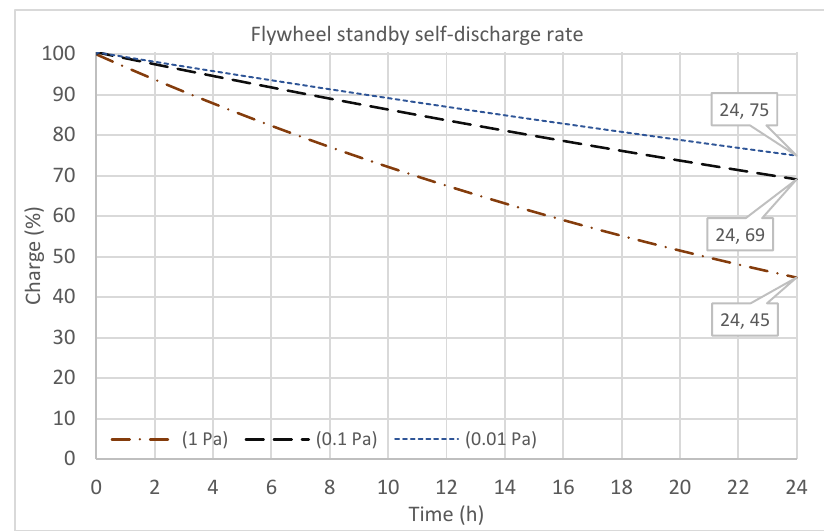
Figure 9. Flywheel standby discharge rate in 24 h.